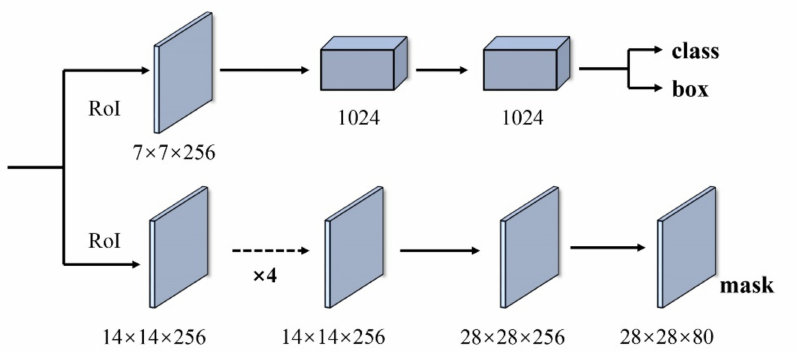
Figure 9. The head architecture we used in the improved Mask R-CNN [6]. RoI: region of